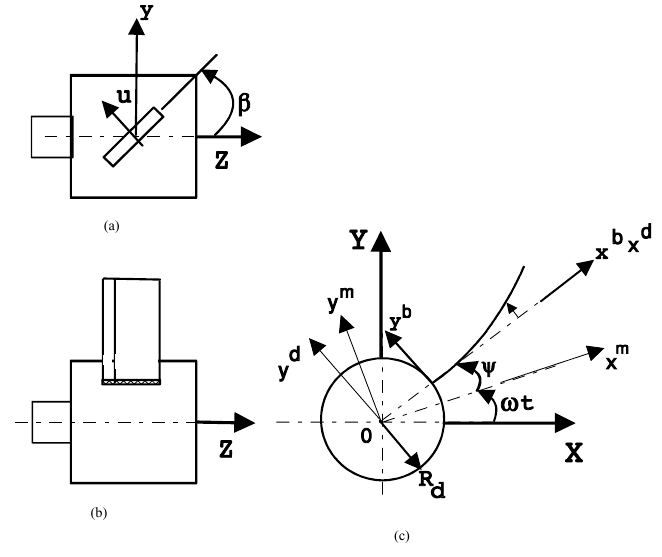
Fig. 1. Schematic of the disk-Blade system and the coordinate